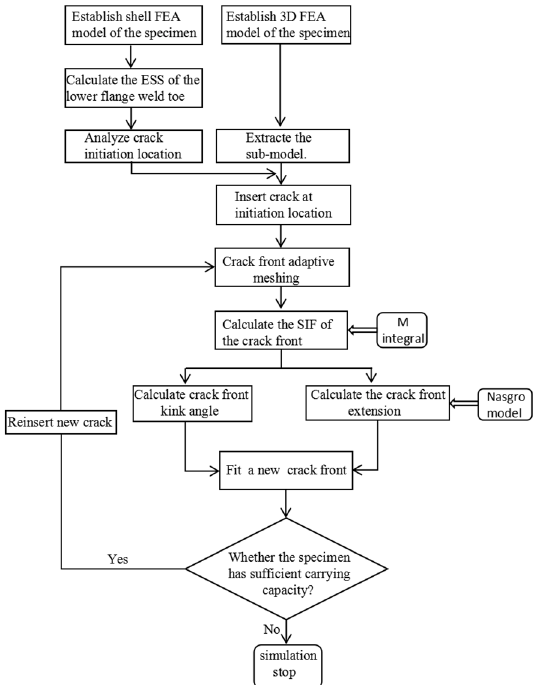
Figure 4. Flow chart of the proposed procedure for the crack propagation simulation.